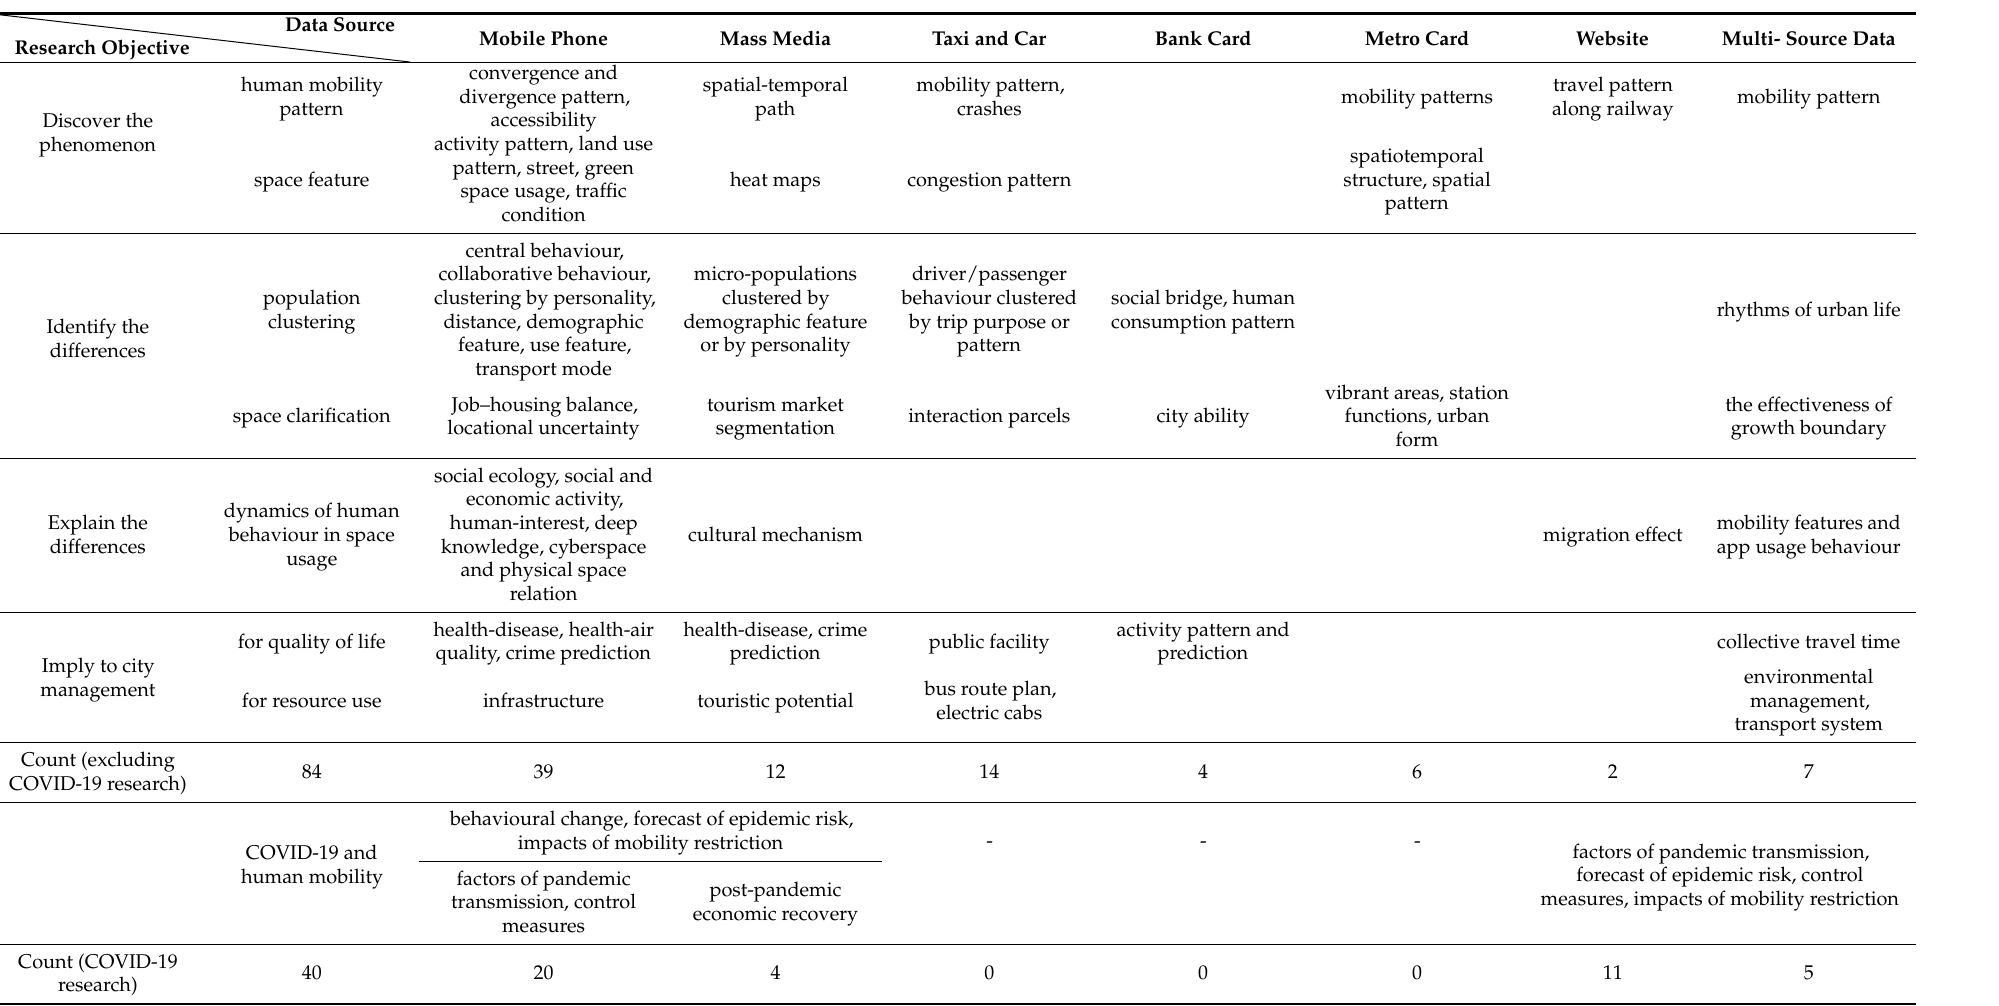
Table 1. The applications of “human mobility” research using big